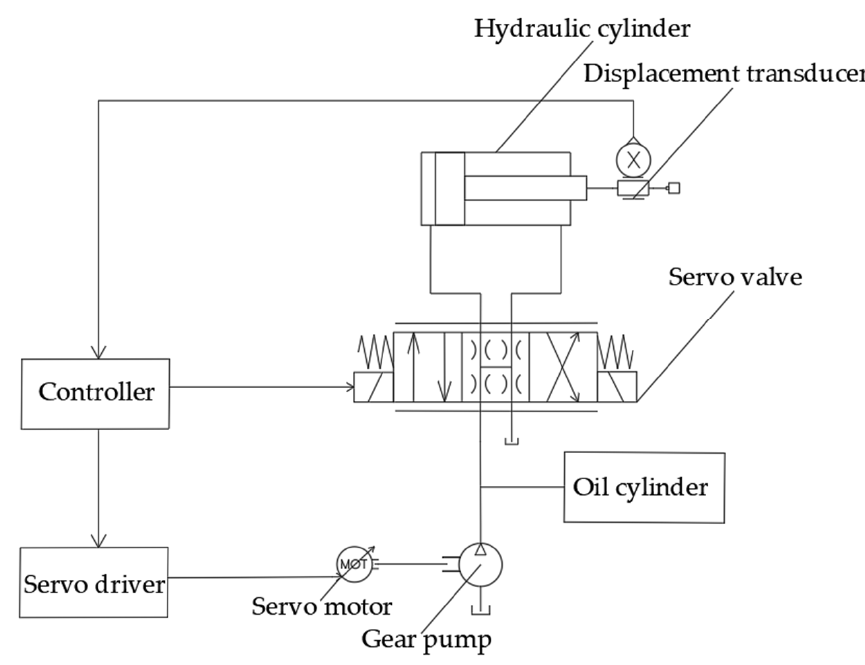
Figure 1. Schematic diagram of valve-controlled hydraulic servo system.